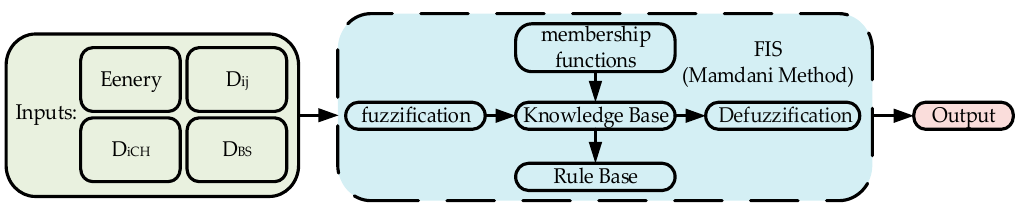
Figure 5. Fuzzy system model.